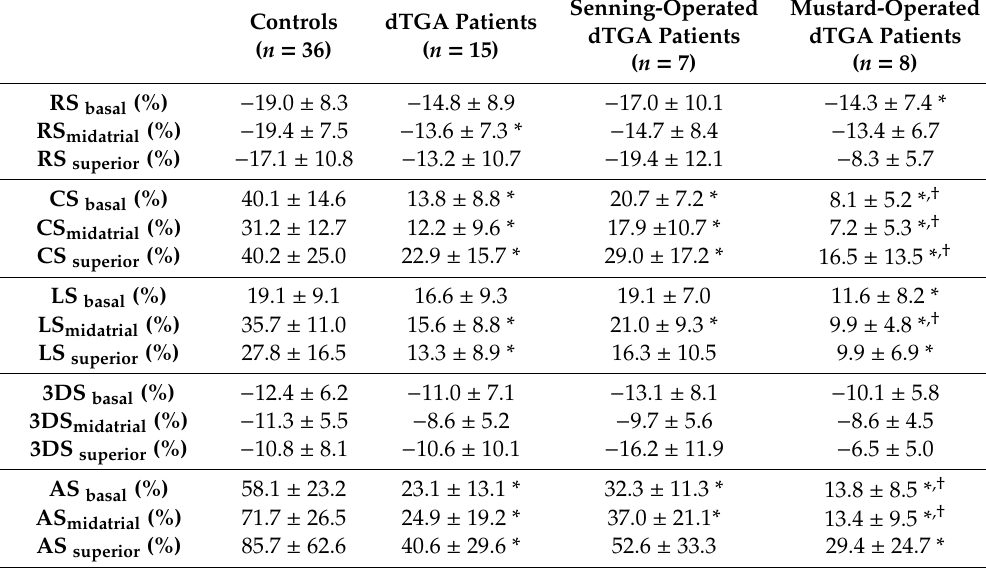
Table 4. Comparison of three-dimensional speckle-tracking echocardiography-derived peak regional left atrial strains of patients with dextro-transposition of the great arteries and those of controls.